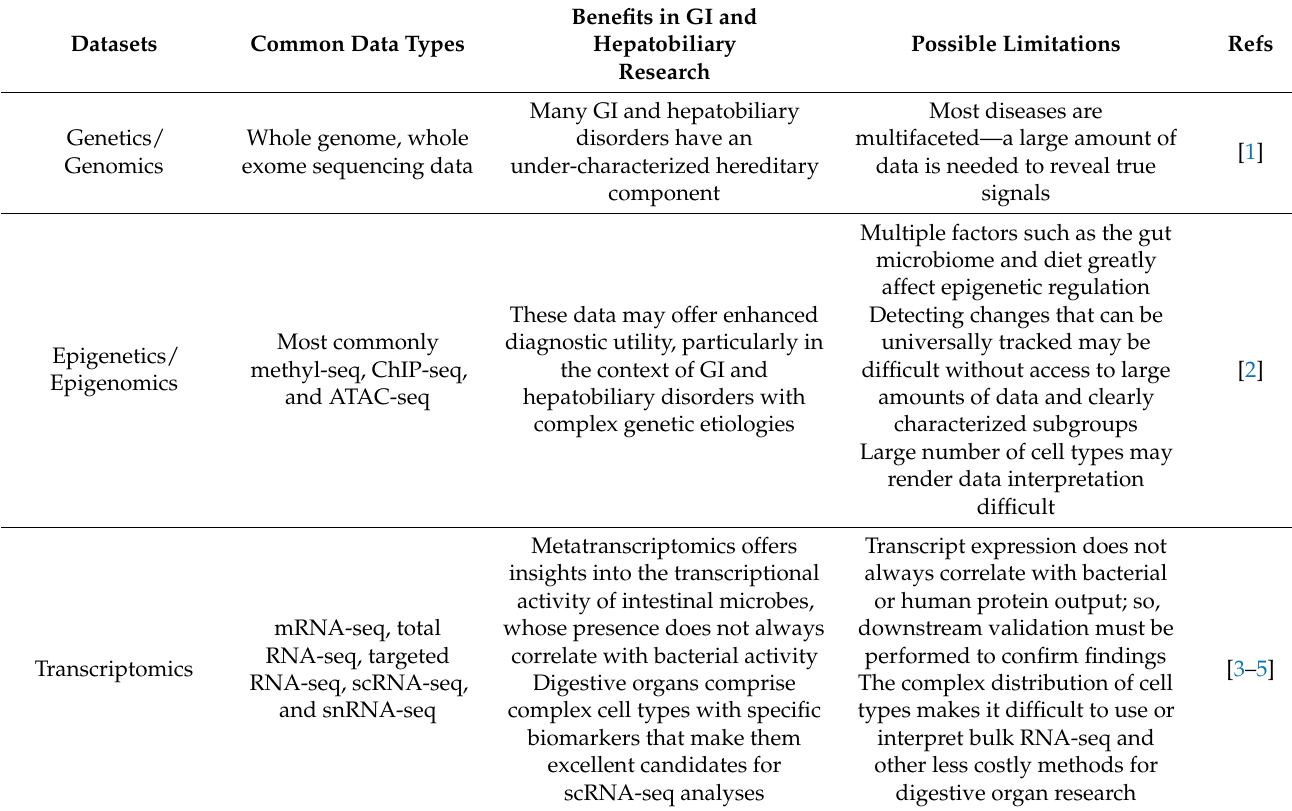
Table 1. Benefits and limitations to using particular datasets in GI and hepatobiliary